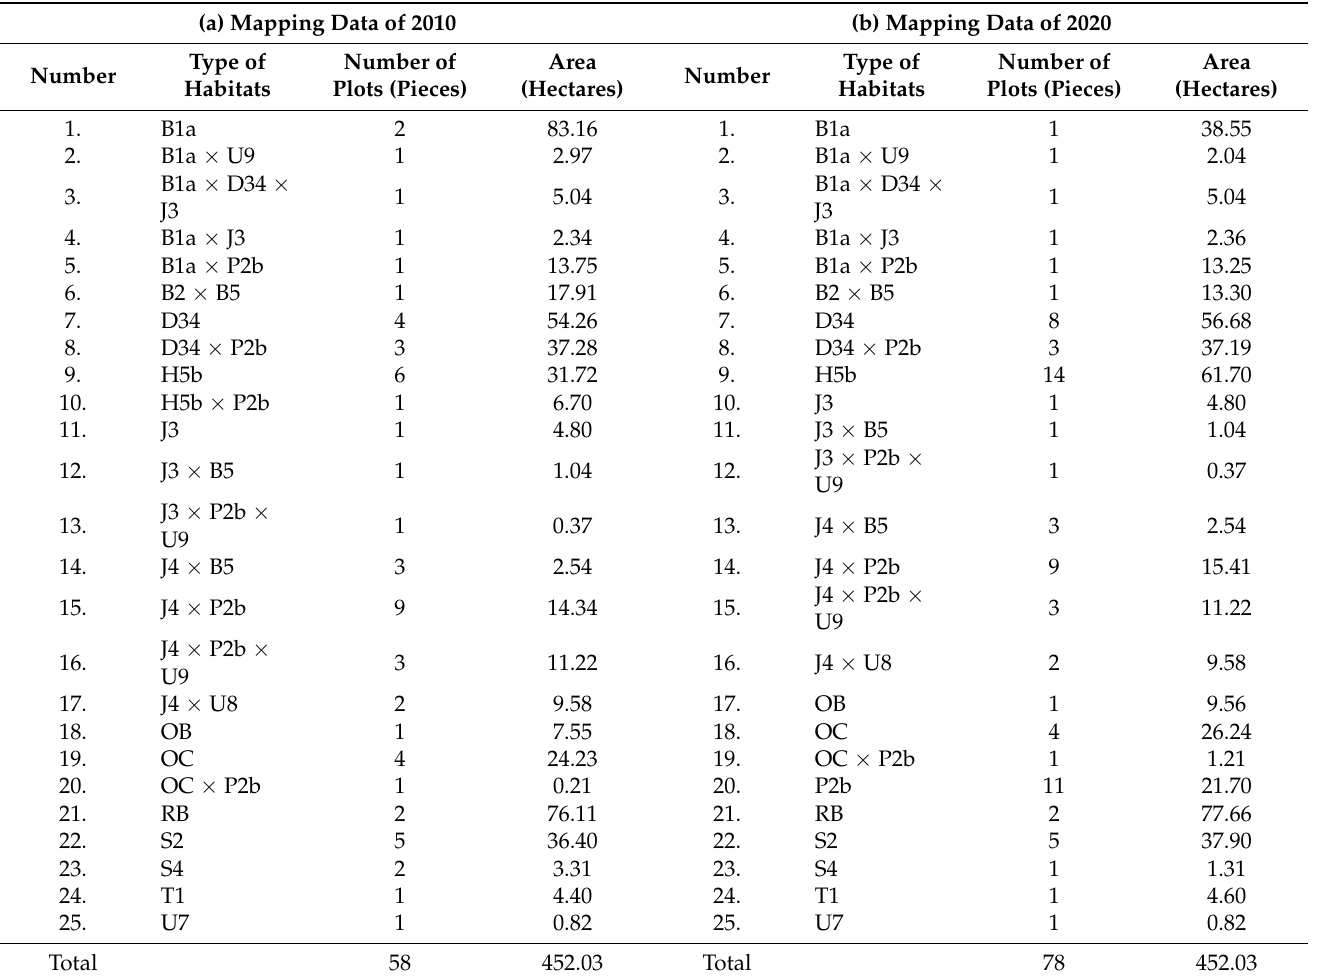
Table 2. Data of the areas of different years (2010 and 2020) of the habitat